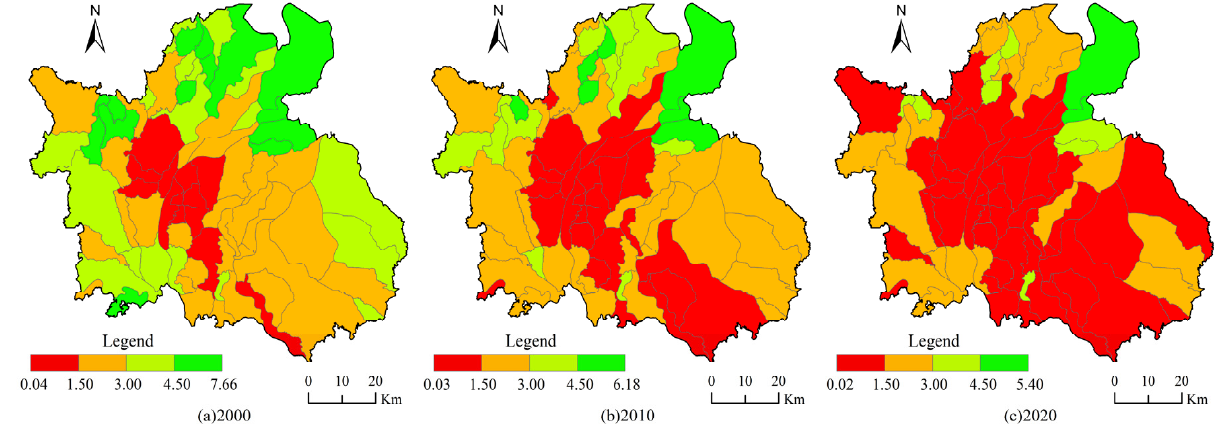
Figure 4. Spatial evolution of density resilience of Nanchang City based on water network group.